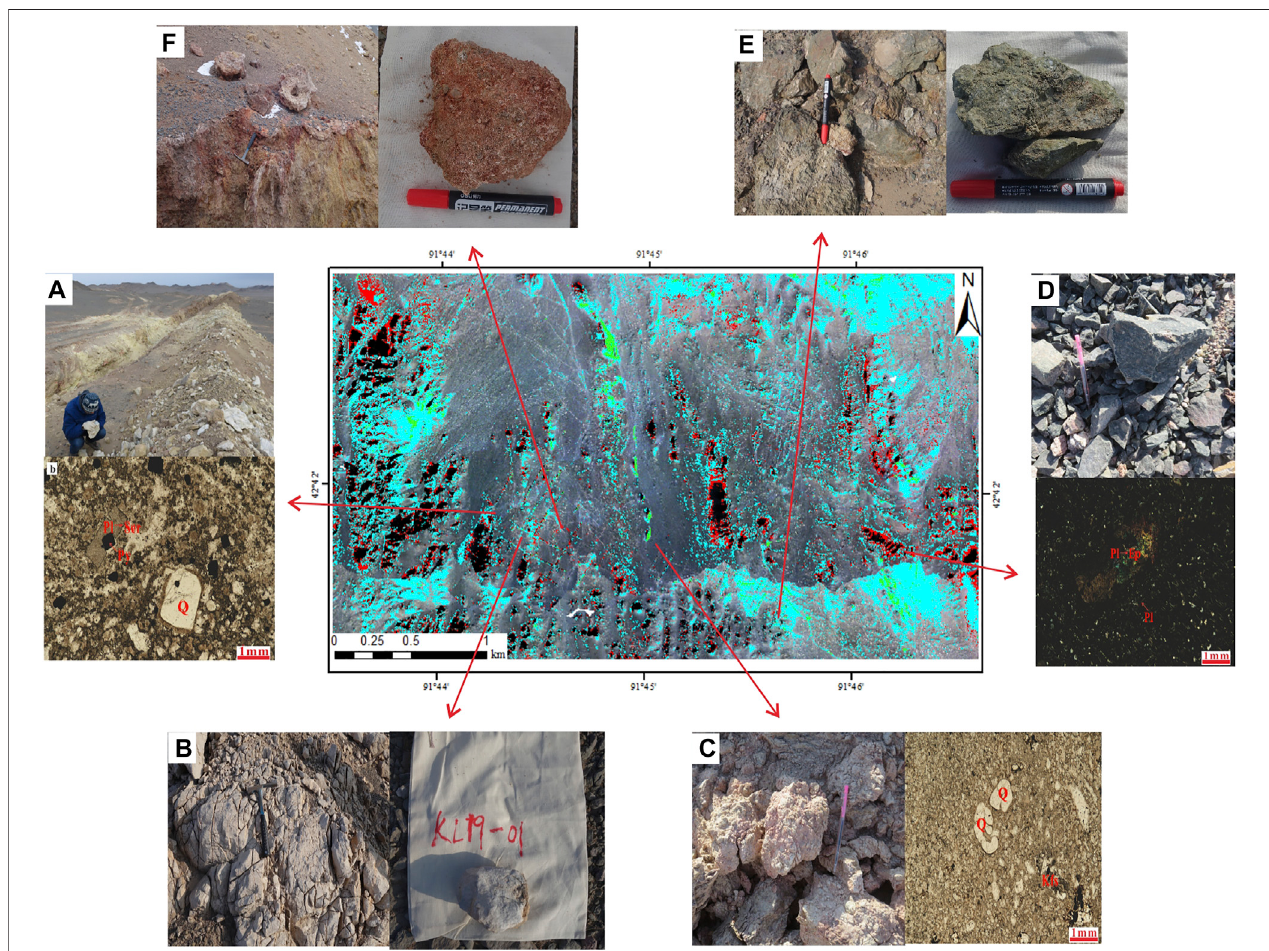
FIGURE 9 | Accuracy evaluation map, hand specimen photographs, and thin section photomicrographs at 10-fold magni fi cation. (A) Iron oxide minerals, (B) clay alteration minerals, (C) clayalteration minerals, (D) propylitic alteration minerals, (E) propyliticalteration minerals, and (F) iron oxide minerals. Qtz, quartz;Pl,plagioclase; Ser, sericite; Py, pyrite; Ep,